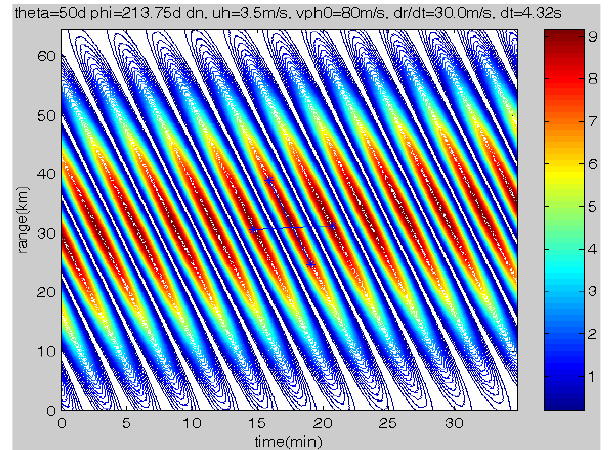
Fig. 4. Same as Fig. 2, except that the preset parameters were: τ 0 = 5 . 5 min, v ph 0 = 80m/s, τ b = 5 . 0 min, u h = 9.5m/s, H = 8km, θ = 50 ◦ , and φ = 213 . 75 ◦ . Fig.4 Same as Fig.2 except the preset parameters were: min5.5